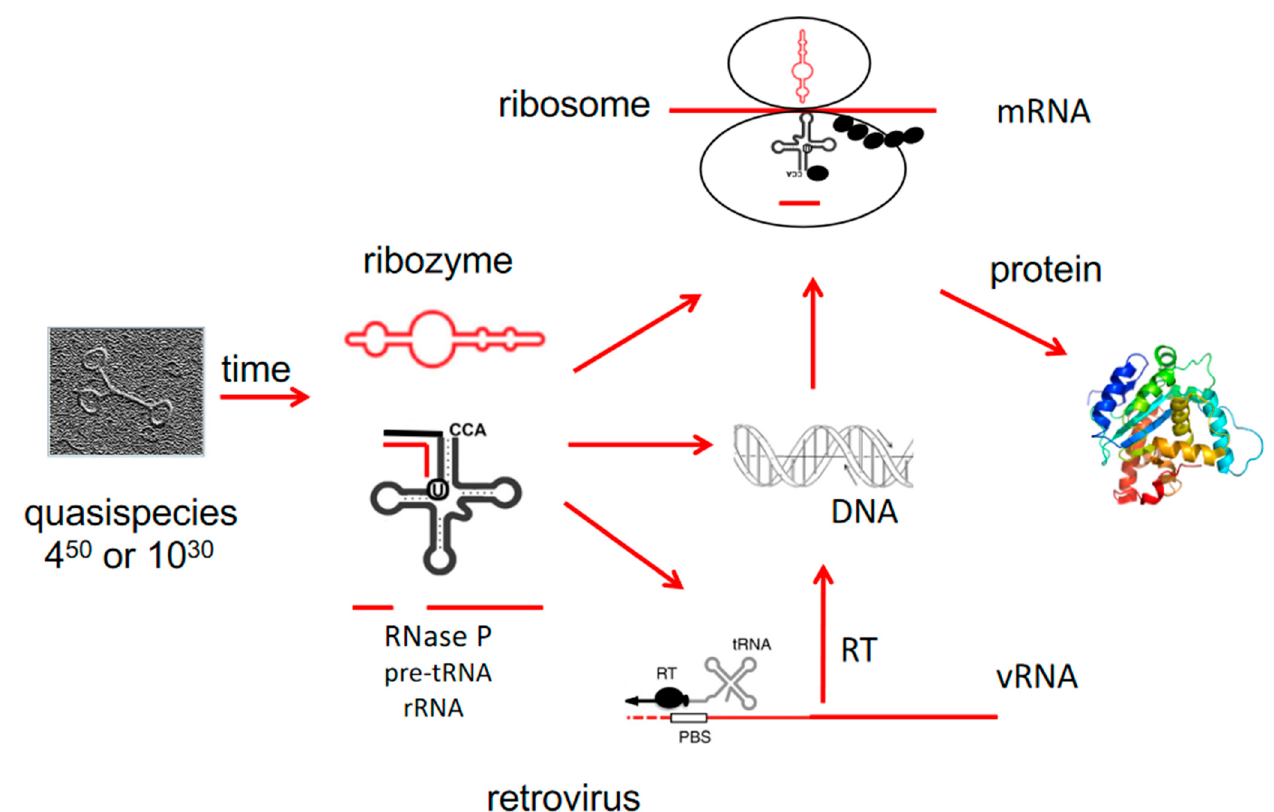
Figure 1. Viroids/viroid-like RNAs/ribozymes early during evolution. The picture shows a viroid. Viroid/ribozymes and tRNAs can form spontaneously from a quasispecies of many RNA molecules, both exhibit enzymatic activities. The ribozyme RNase P processes pre-tRNA to the shorter tRNA, DNA can arise from RNA without a reverse transcriptase (RT), protein synthesis in ribosomes requires ribozymes as essential components (mRNA is messenger RNA, vRNA is viral RNA, PBS is the primer binding site for tRNA binding) (For details see text).